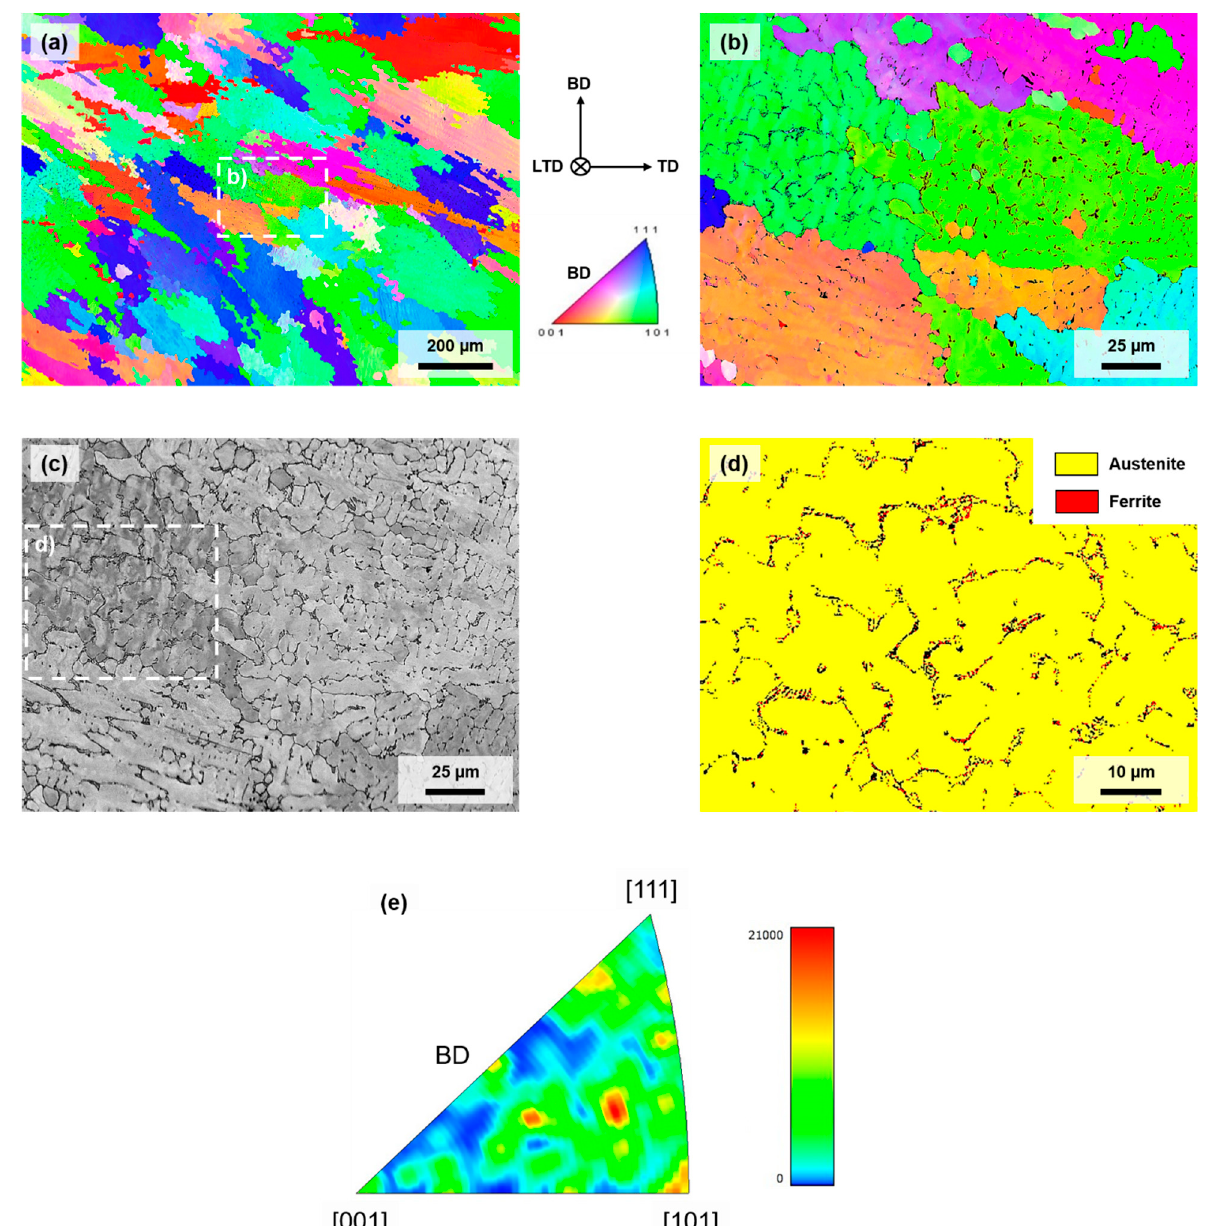
Figure 3. ( a ) EBSD inverse pole figure (IPF) map of an as-built DED SS 316L specimen. ( b ) A magnified view of the marked white dashed rectangle in ( a ). ( c ) Image quality map highlighting the grain structures in addition to the IPF map in ( b ). ( d ) EBSD phase map of the marked white dashed rectangle in ( c ). The grain orientations in ( a , b ) are plotted with respect to the build direction (BD). ( e ) Inverse pole figure calculated from EBSD data of the micrograph shown in ( a ) revealing the micro-texture of the DED SS 316L. Data are plotted with respect to the BD.